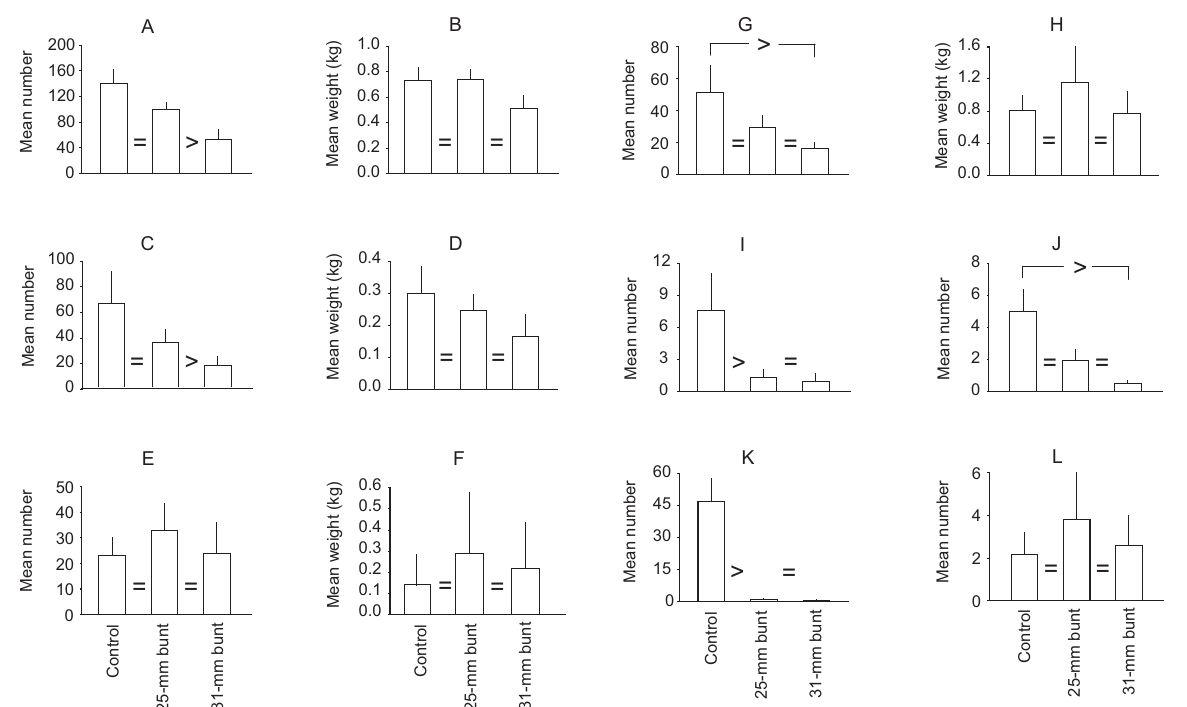
F IG . 6. – Differences in mean catch (+ SE) between the control and 25 and 31 mm bunts used in experiment 2 for A) number and B) weight of total prawns, C) number and D) weight of eastern king prawns, E) number and F) weight of school prawns, G) number of greasyback prawns, H) weight of bycatch and numbers of I) hardyhead, J) river garfish, K) glassy perchlets and L) broad squid. > and = indicate signif icant differences determined by SNK tests.